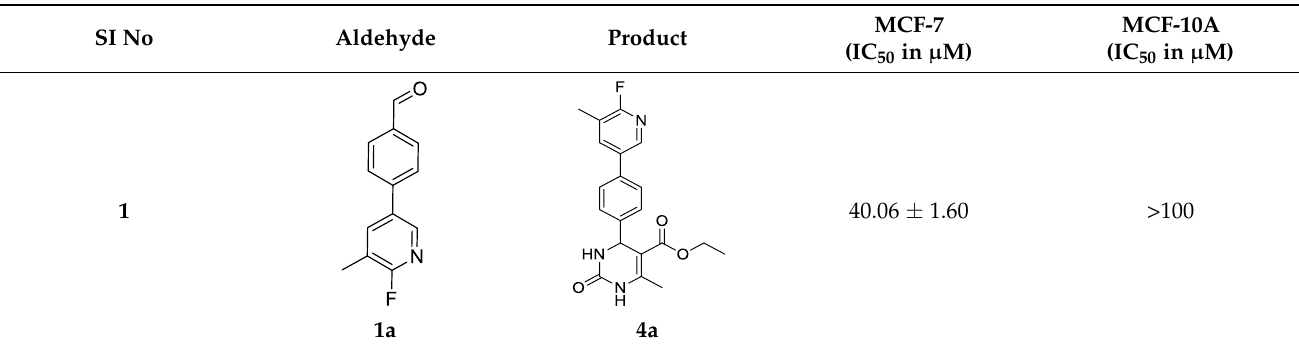
Table 1. Tabular representation of the Biginelli reactants and products used in this study and their cytotoxicity data on human breast cancer MCF-7 cells. IC 50 is a measure from three independent experimental wells.